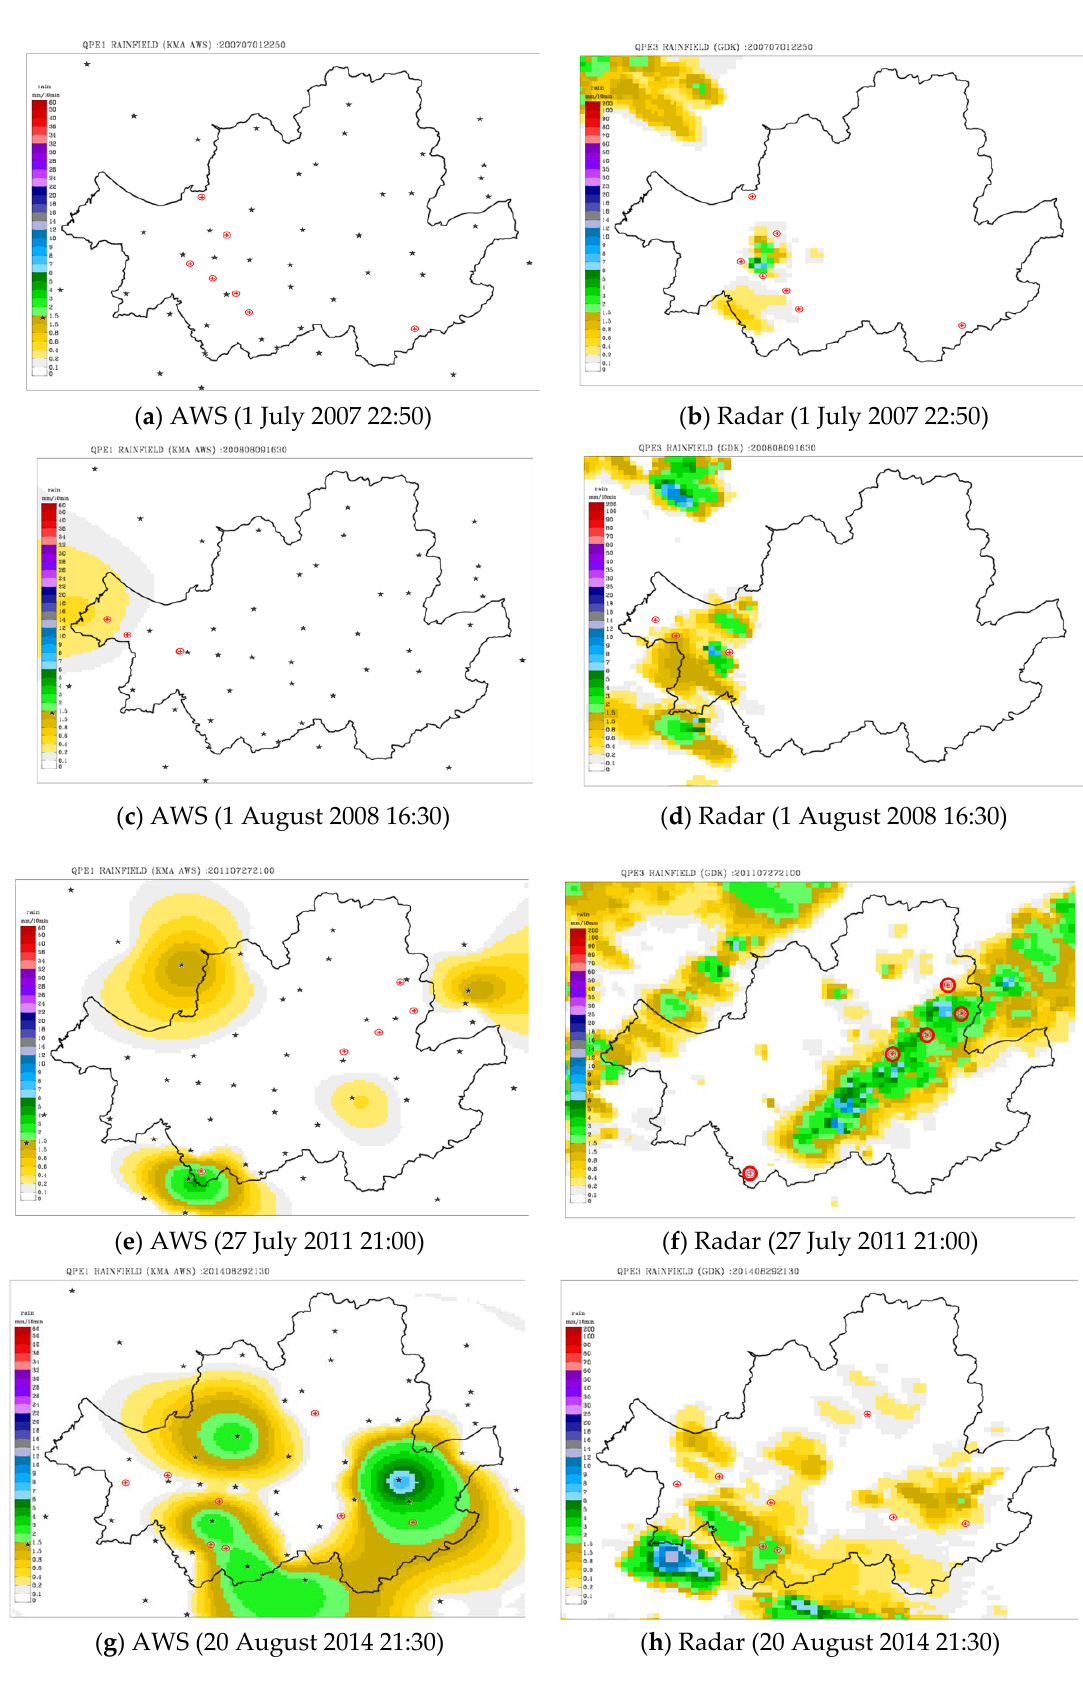
Figure 5. Comparison of interpolated AWS (left column) and radar-derived (right column) rainfall distribution with traffic accident locations (red circles) for localized rain events.